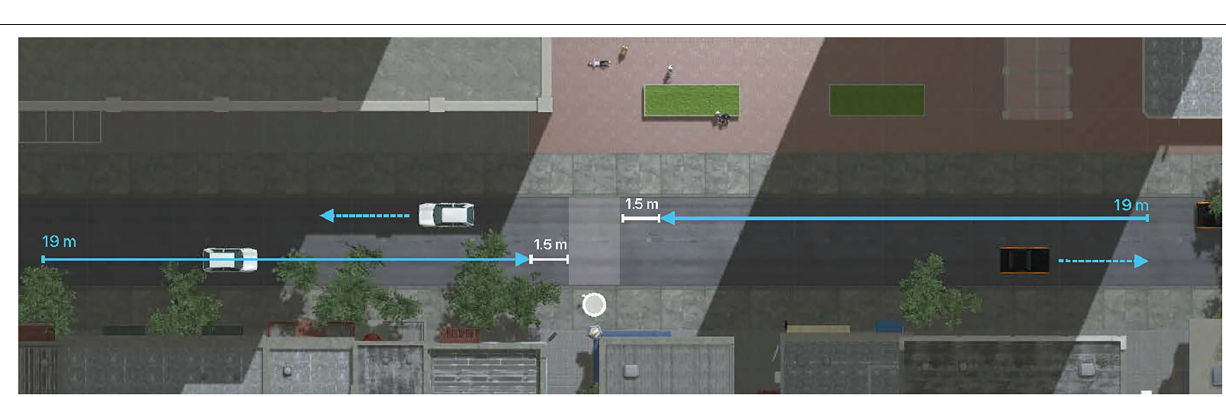
FIGURE 4 | A top-down view of the virtual environment zooms in on the midblock location where participants made the crossing. Dotted blue arrows indicate the travel direction of AVs. Solid blue arrows indicate where the AVs (on each lane) begin to decelerate and where they come to a complete halt. The white circle indicates the pedestrian position at the start of each experimental